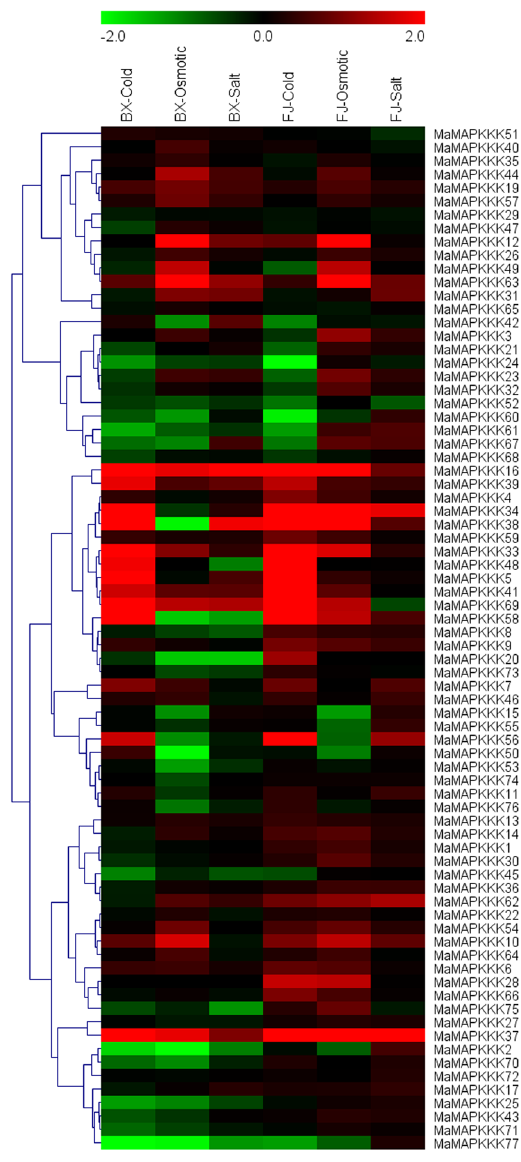
Figure 10. Expression profiles of banana MAPKKKs in response to cold, osmotic and salt treatments in BX and FJ varieties. Log2 based FPKM value was used to create the heat map. Changes in gene expression are shown in color as the